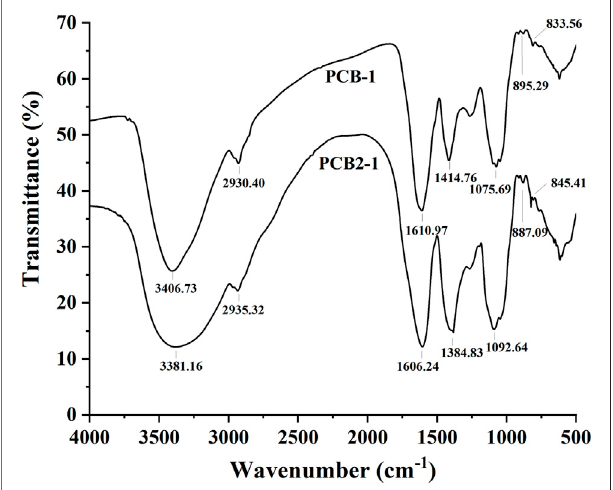
FIGURE4| FT-IRspectraofpolysaccharidesisolatedfrom P.cablin :FT- IR spectrum of PCB-1 and